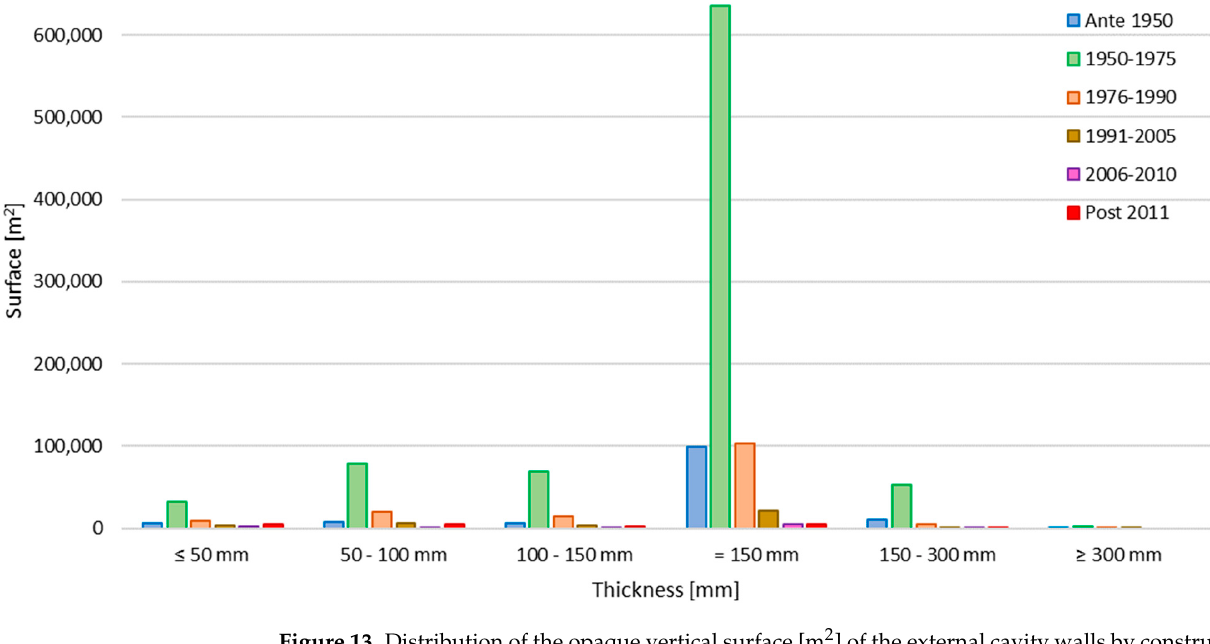
Figure 12. EPC distribution by wall without cavity and wall with cavity [%].